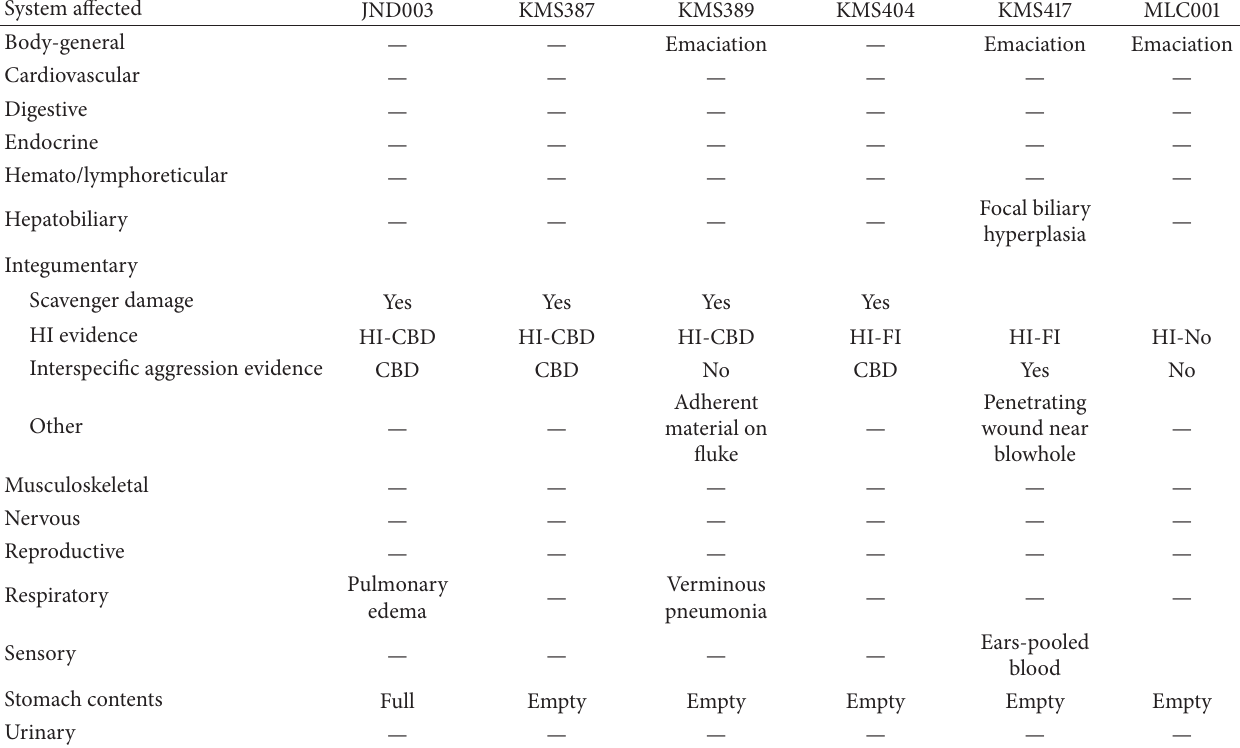
Table 2: Specific gross necropsy findings by system for the six harbor porpoises with submitted tissues for histopathologic evaluation. Each porpoise is listed by its field identification number. Cells for human interaction (HI) evidence are listed as follows: HI-FI (evidence of fishery interaction), HI-No (no evidence of HI), and HI-CBD (could not be